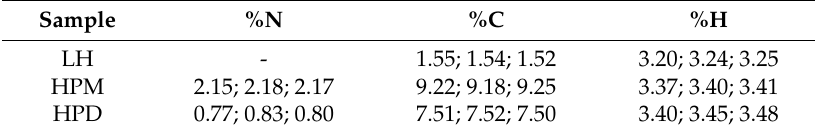
Figure 5. SEM micrographs of studied samples: ( a ) LH; ( b ) HPM; ( c ) HPD. Table 3. Elemental analysis of hybrid pigments.